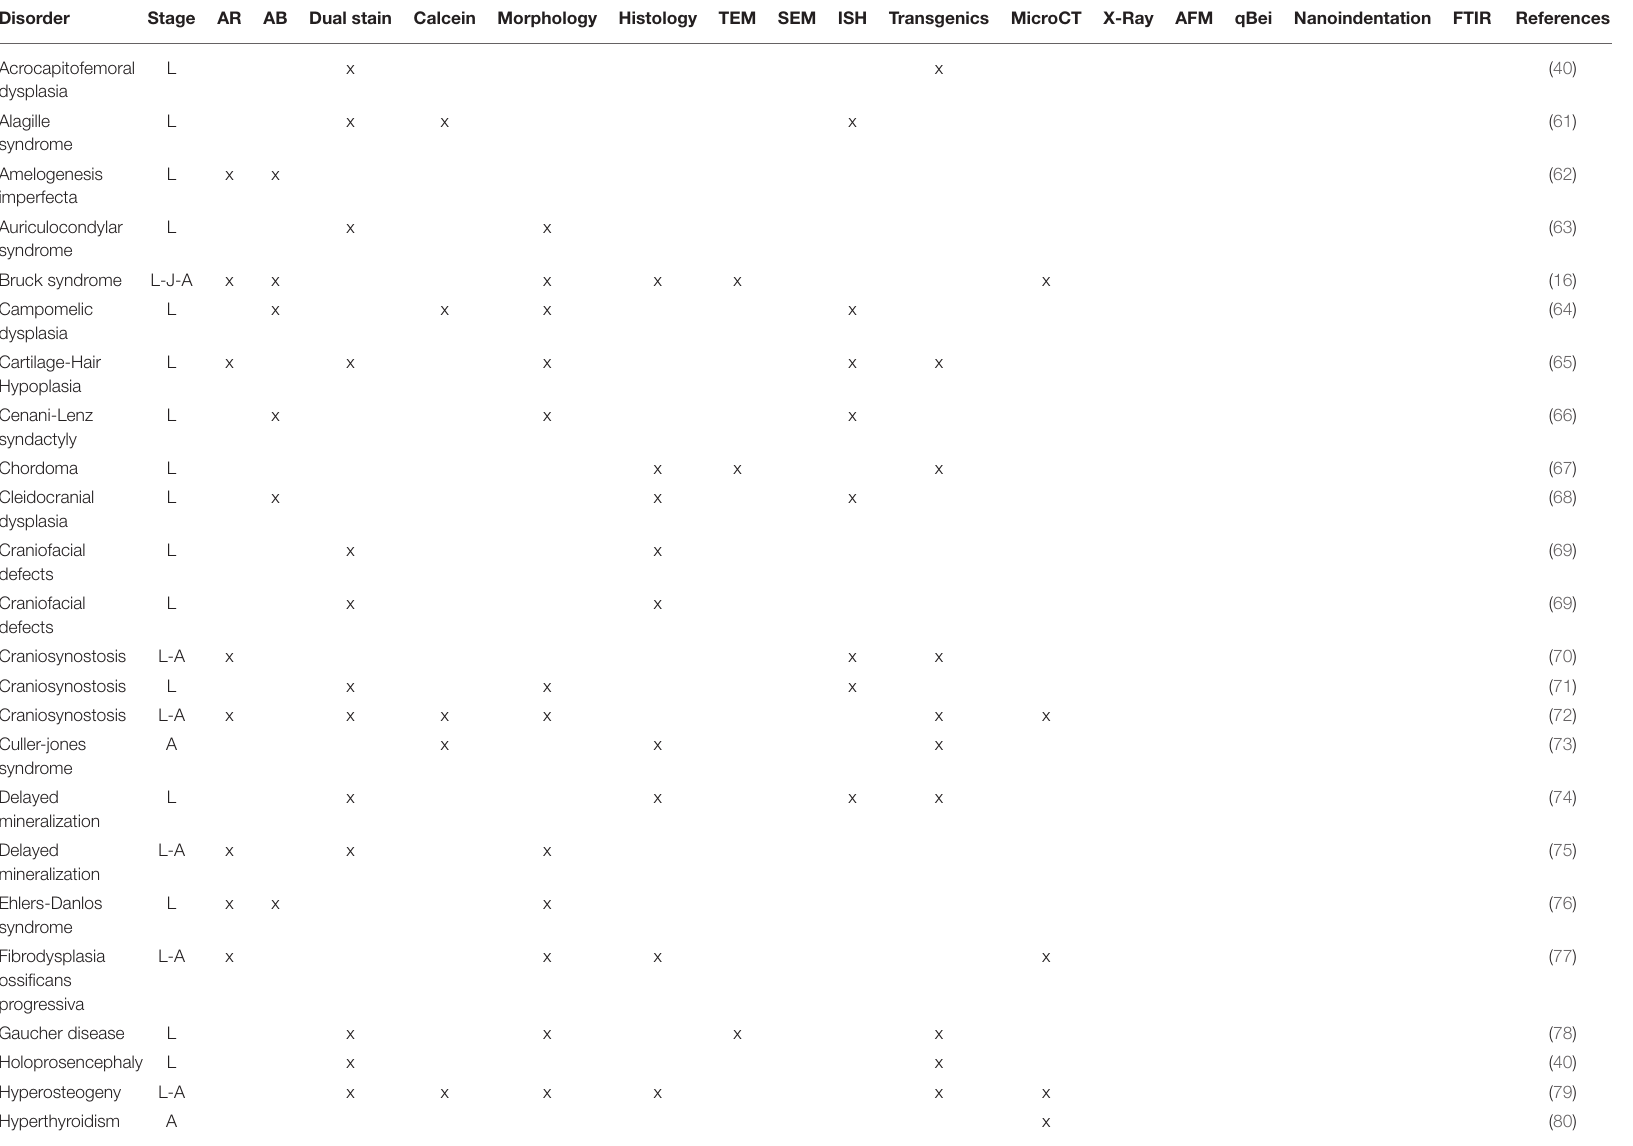
TABLE 3 | Techniques applied to evaluate bone phenotype in zebrafish models.